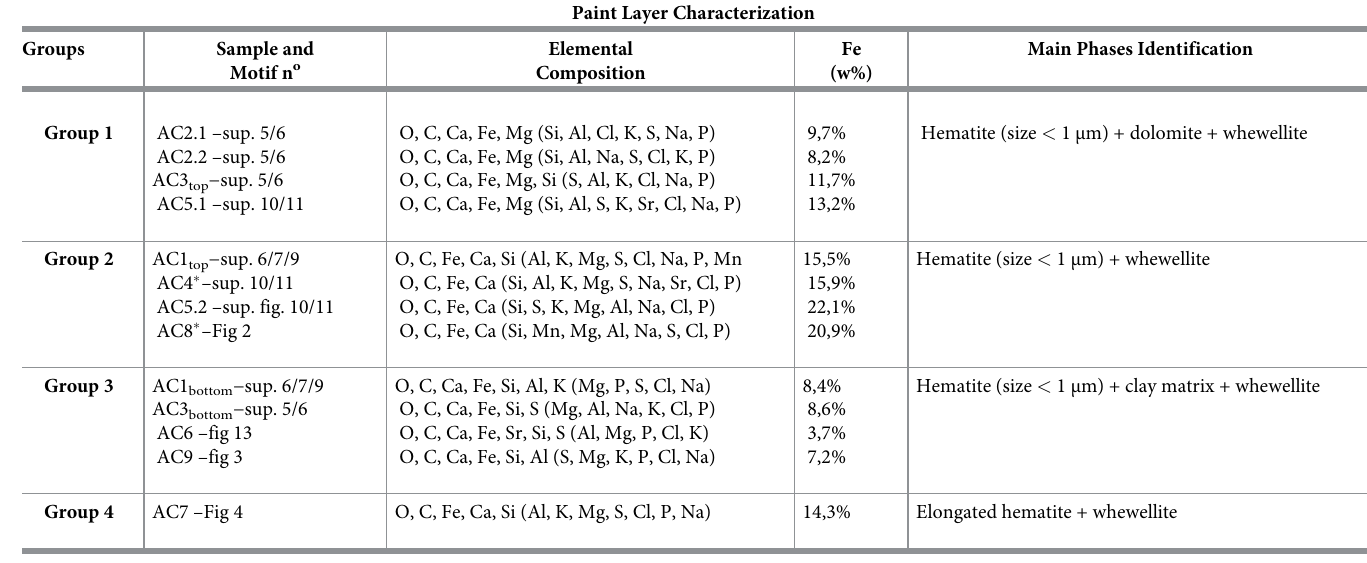
Table 2. Results of the analyses of the pictorial layers of cross-sections AC1-AC9, divided into four groups according to the paint mixtures identified. The percen- tual amount of the elements within brackets are < 1%. Quantitative micro-analyses are reported in S1 Table 2 in S1 File. � for sample AC4 and AC8 the results of the top layer are reported. (sup. =